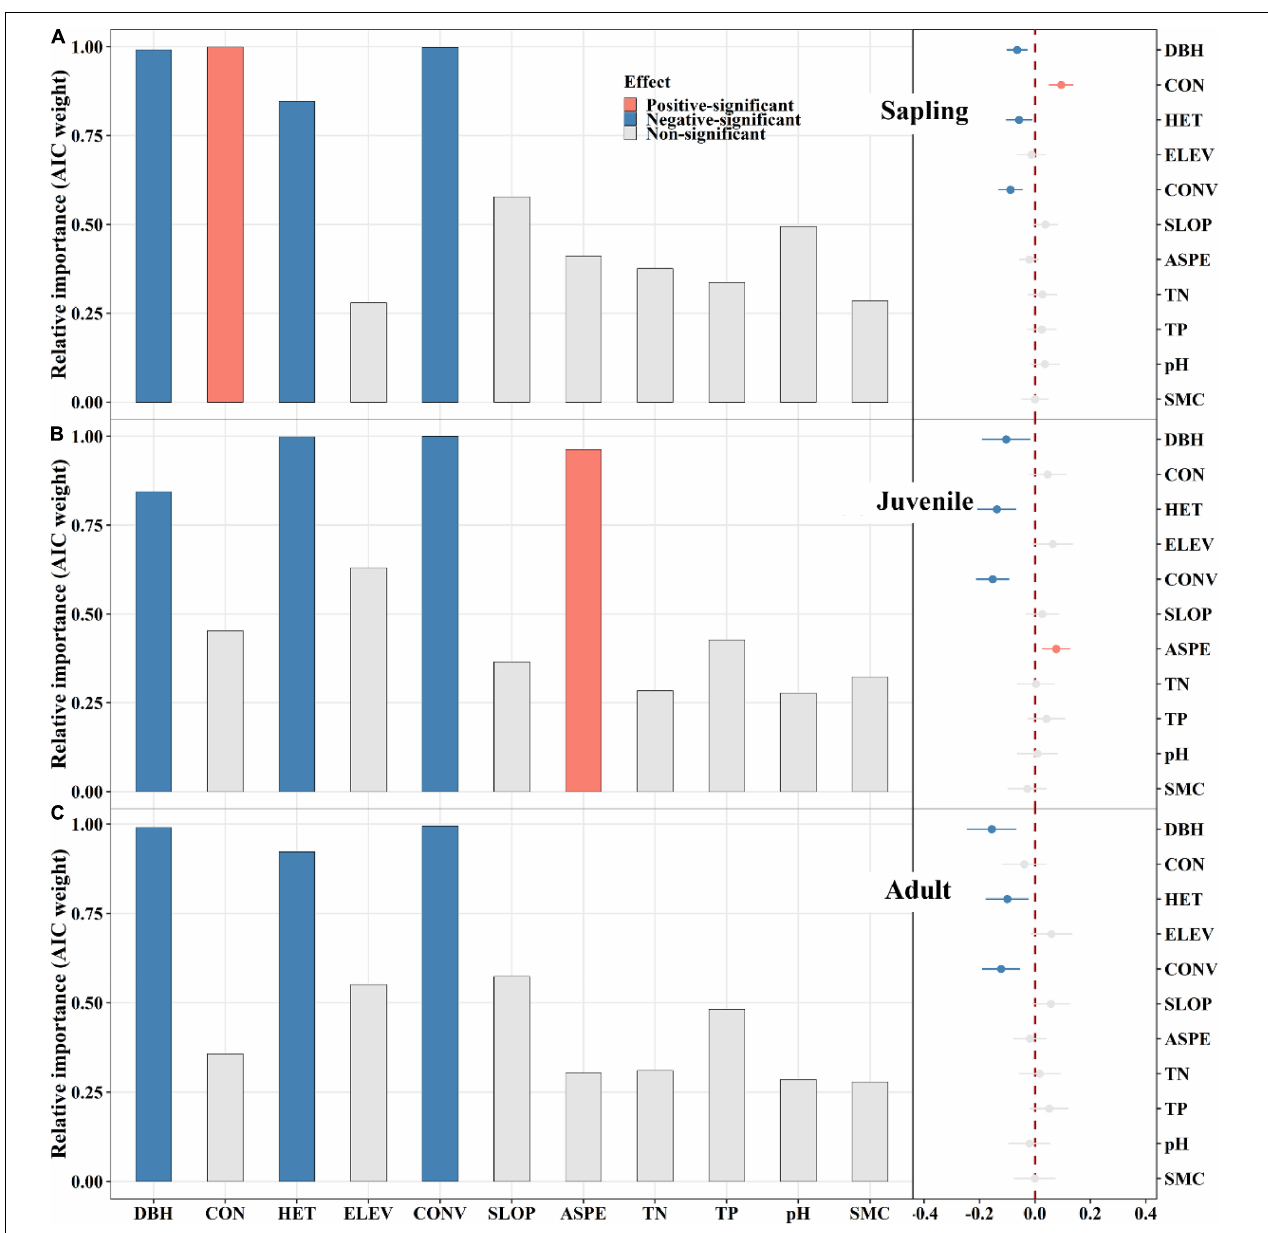
FIGURE 3 | The relative influence of potential variables on tree mortality in sapling (A) , juvenile (B) , and adult (C) stage. The variables examined are the log-transformed initial DBH of tree (DBH), conspecific neighborhood index (CON), heterospecific neighborhood index (HET), elevation (ELEV), slope (SLOP), aspect (ASPE), convexity (CONV), total nitrogen (TN), total phosphorus (TP), pH value (pH) and moisture content (SMC) of soil. Error bars represent 1.96 ∧ β j ). Blue and red points indicate that parameter estimates differ significantly from zero at the level of alpha = model-average estimator (